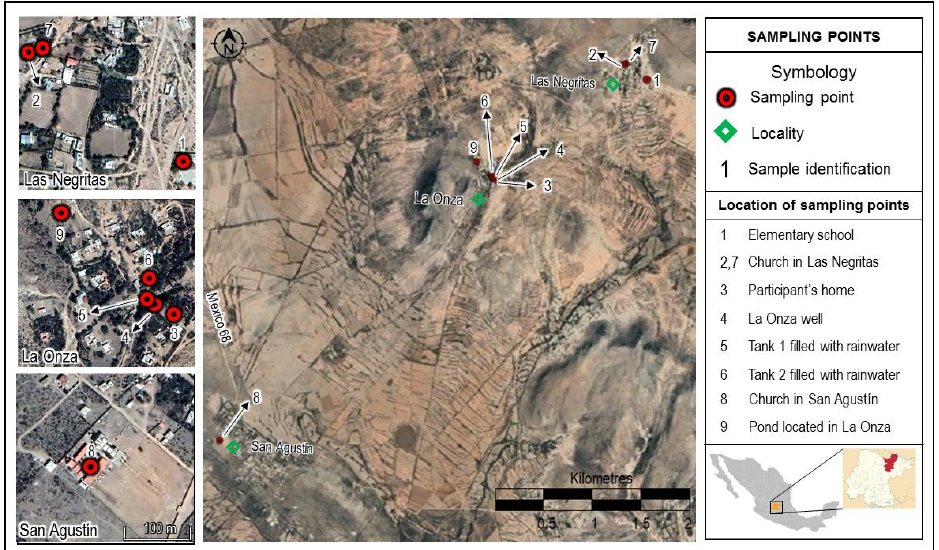
Figure 1. Study site in the high basin of the Laja River in Guanajuato, Mexico, and water sampling sites.